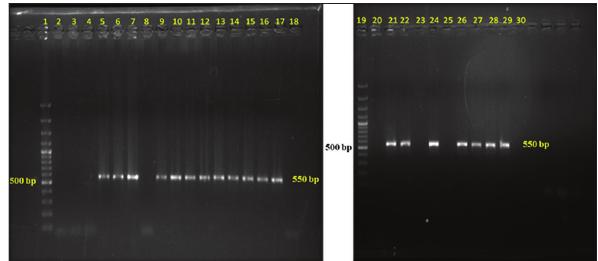
Figure-1: Gel electrophoresis image of polymerase chain reaction amplified products of bla gene of Gram- CTX-M negative isolates; Lane 1 - 1500 bp DNA ladder; Lane 2-14, 16-19 - Isolated Escherichia coli samples; Lane 15 - Positive control for bla gene; Lane 20 - Negative CTX-M control.